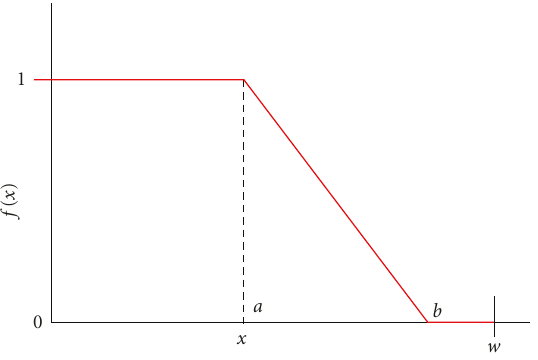
Figure 3: Shape of the basic smoothing function.